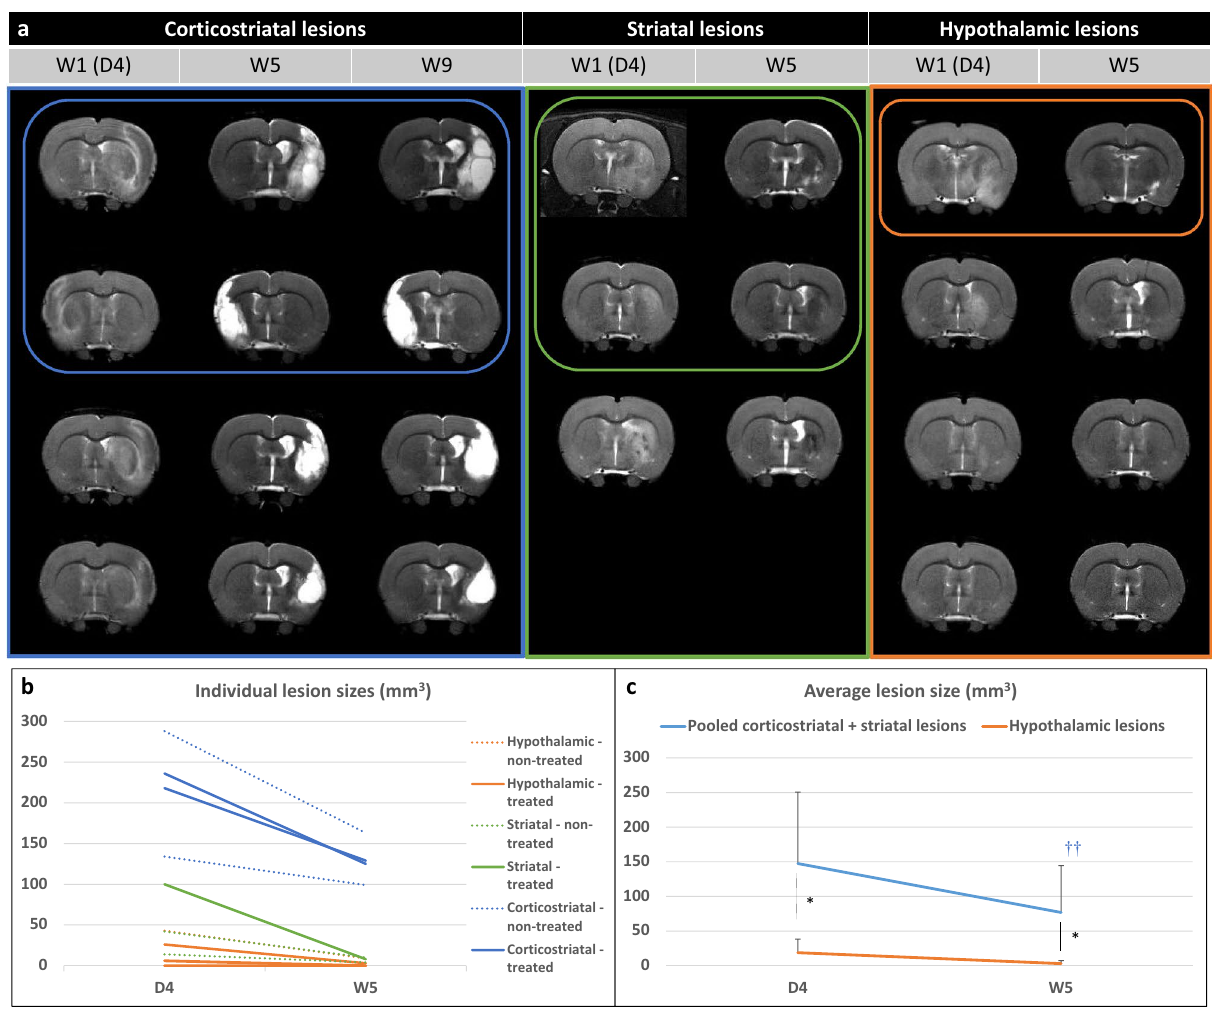
Figure 2. Evaluation of lesions on T2-weighted imaging. ( a ) Longitudinal T2-weighted imaging of all included rats according to lesion subtype (only one central slice is shown). Treated rats (that received intracerebral administration of hASCs) are presented in top rows and circled. ( b ) Individual lesion sizes are presented according to lesion subtype (striatal, corticostriatal and hypothalamic lesions) and treatment group (plain line: treated; dashed line: non-treated) at day 4 (D4) and week 5 (W5) post-surgery. ( c ) Average lesion sizes are presented according to lesion subtype: pooled (corticostriatal + striatal) vs hypothalamic lesions. Data are displayed as mean ± SD. W weeks, D days; *p < 0.05, (corticostriatal + striatal) vs hypothalamic, Wilcoxon– Mann–Whitney test; † p < 0.05, †† p < 0.01, W5 vs D4, Friedman